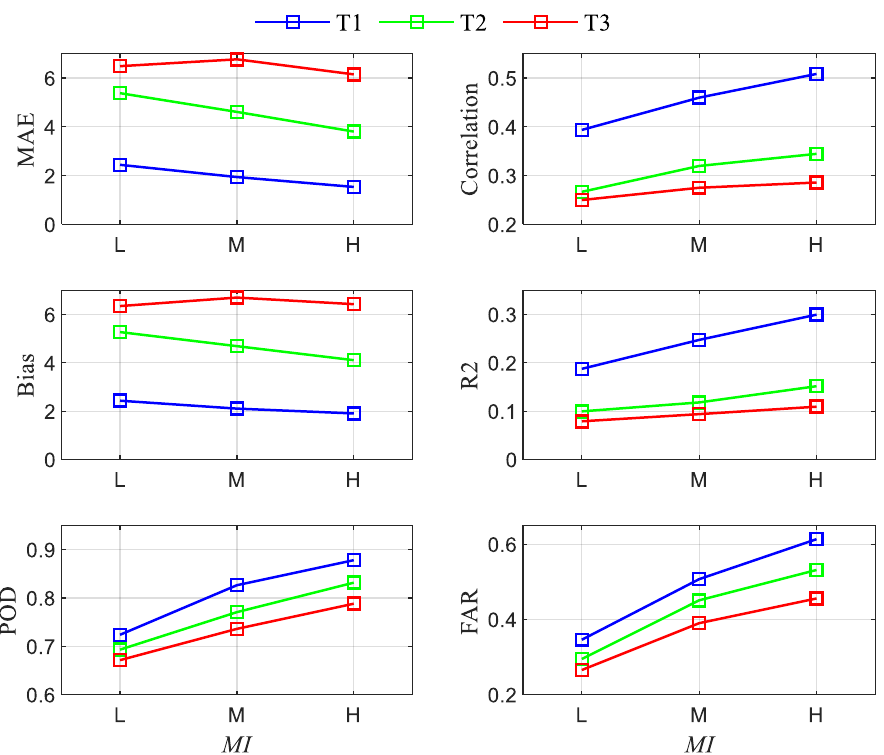
Figure 9. Comparison of rainfall nowcasting skills shown in Figure 5 under different lead times and rainfall spatial Moran’s I values.